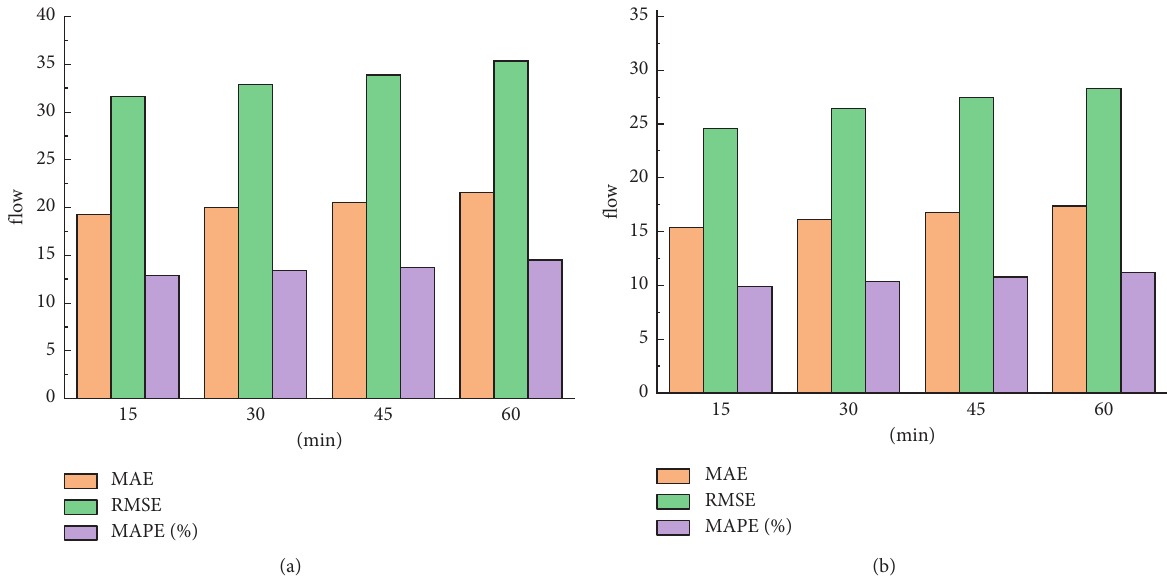
Figure 16: Performance comparison of flow on PEMSD4 and PEMSD8 datasets. (a) Performance comparison of flow on PEMSD4. (b) Performance comparison of flow on